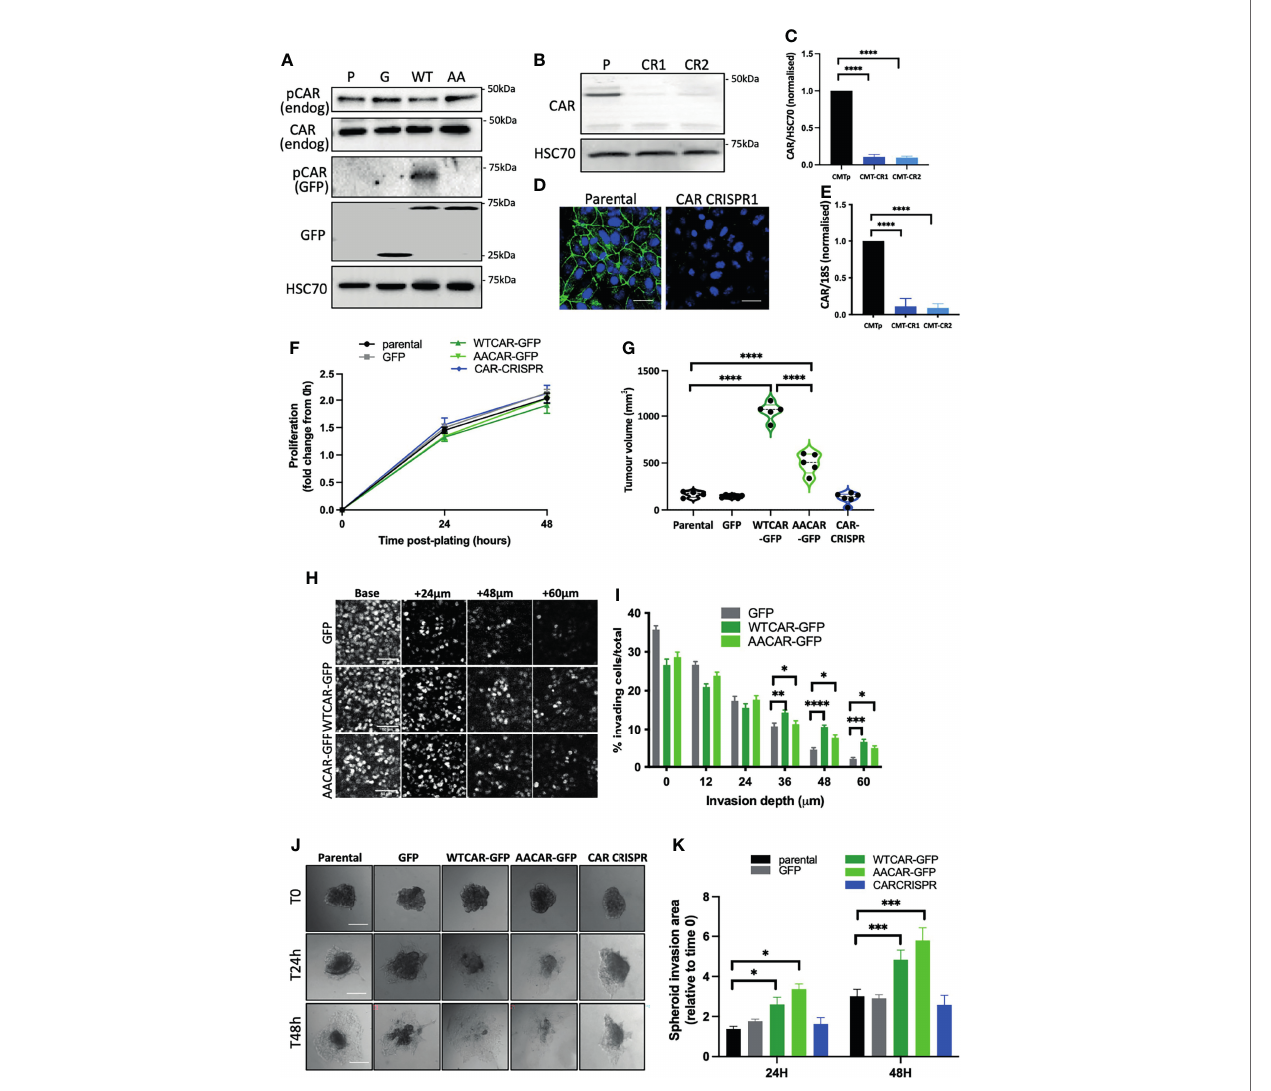
FIGURE 1 | CAR promotes lung cancer progression. (A) Representative Western blots of speci fi ed proteins in CMT 167 cells, parental (P), GFP expressing (G) , WTCAR-GFP (WT) and AACAR-GFP (36). (B) Representative Western blots of CAR levels in parental (P) and 2 different CAR CRISPR CMT 167 cell populations (CR1, CR2). (C) Graph shows quanti fi cation of CAR levels as in (B) from 4 independent experiments. (D) Representative confocal images of parental and CAR CRISPR cells stained for CAR (green) and DAPI (blue). Scale bars are 10 m m. (E) CAR transcript levels in parental and CRISPR cells by qPCR relative to 18S control. Pooled data from 3 independent experiments. (F) Proliferation in speci fi ed CMT 167 cells 24h and 48h post-plating. Data is representative of 3 independent experiments and from 4 replicates per cell line per time point. (G) Tumor volume in mice subcutaneously injected with speci fi ed CMT 167 cells. Violin plots shown with each point represents one animal (n=5 per group). (H) Representative confocal images of nuclei stained in speci fi ed CMT 167 cell lines at intervals through 3D inverted invasion assay. Scale bars are 50 m m. (I) Quanti fi cation of invasion data from (H) at different depth intervals, pooled from 4 different wells per condition, representative of 3 independent experiments. (J) Representative phase contrast wide fi eld images of speci fi ed CMT 167 cell spheroids images over time. Scale bars are 100 m m. (K) Quanti fi cation of spheroid area over time relative to time 0. 10 spheroids per cell line analysed; representative of 3 independent experiments. All values are mean ± SEM. P values *p < 0.05,**p < 0.01, ***p < 0.0005, ****p <